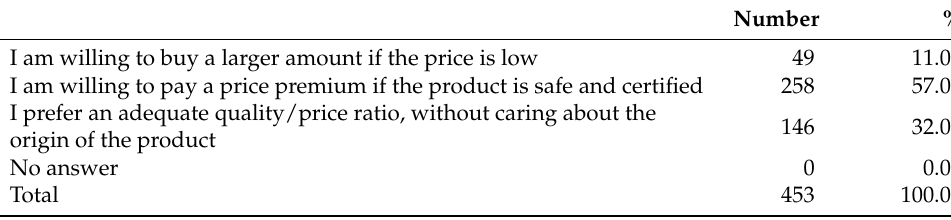
Table 7. Apulian consumers’ behavior related to sea urchin purchasing.